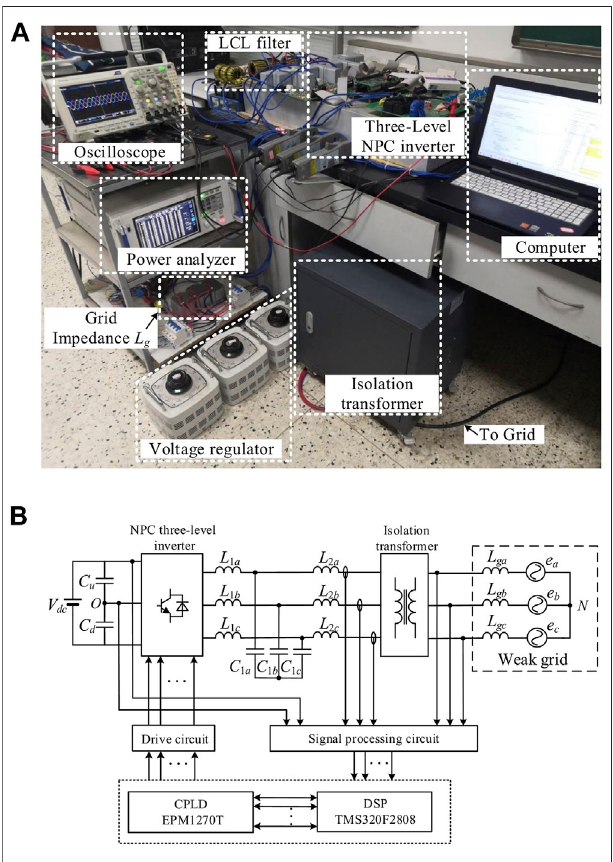
FIGURE 7 | Schematic diagram and experimental photograph of the system. (A) Schematic diagram of the system. (B) Experimental photograph of the